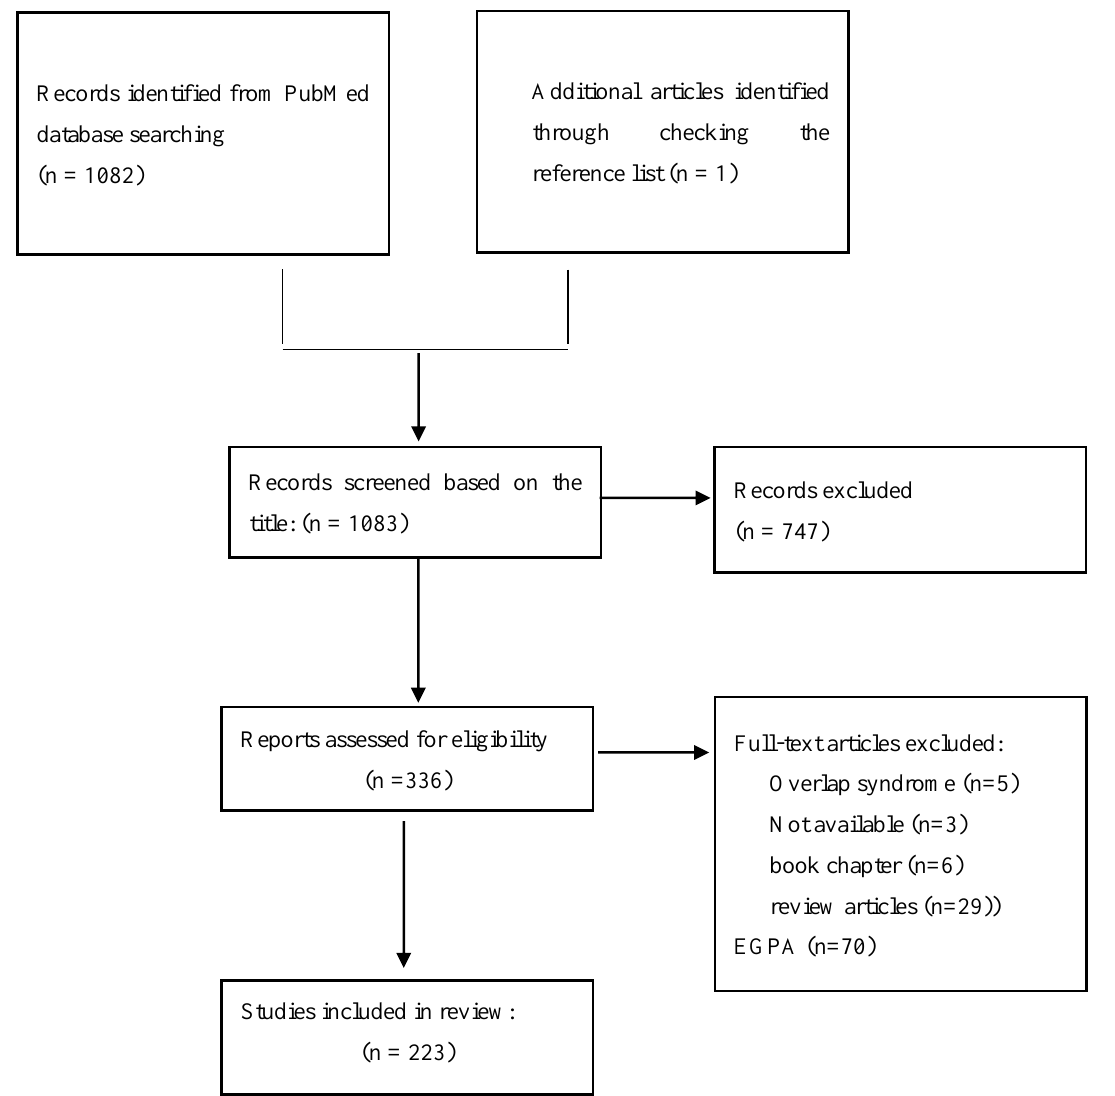
Figure 1. Preferred Reporting Items for Systematic Reviews and Meta-Analyses (PRISMA).